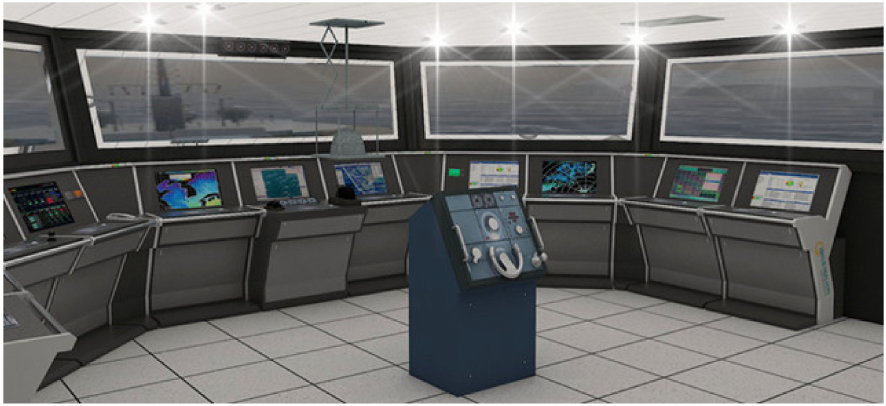
Figure 4. Mockup bridge of